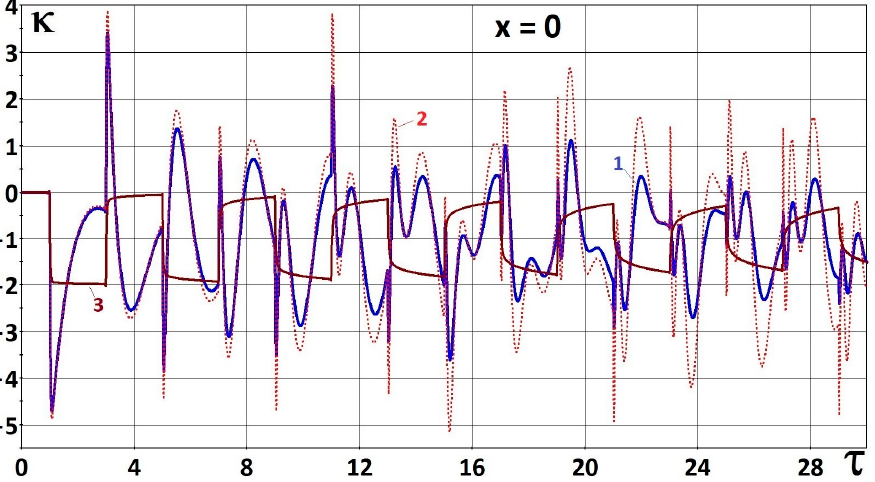
Figure 3. Relative stress–time history at x = 0 for viscoelastic FGM—curve 1, for elastic FGM—curve 2, for homogeneous viscoelastic material—curve 3.